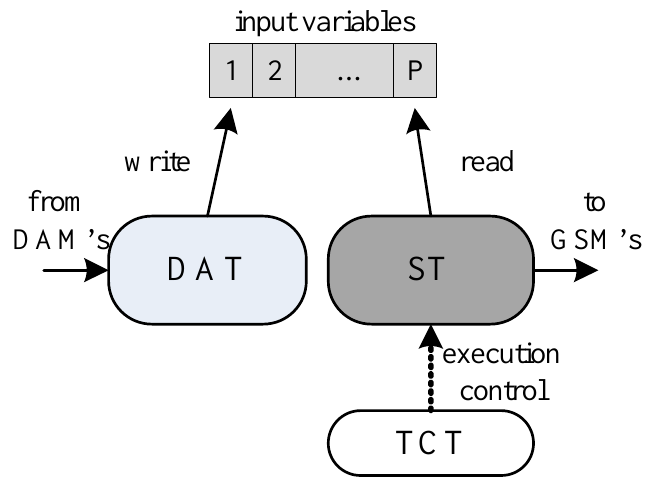
Figure 3. Relationships between the data acquisition thread (DAT), the simulation thread (ST) and the time control thread